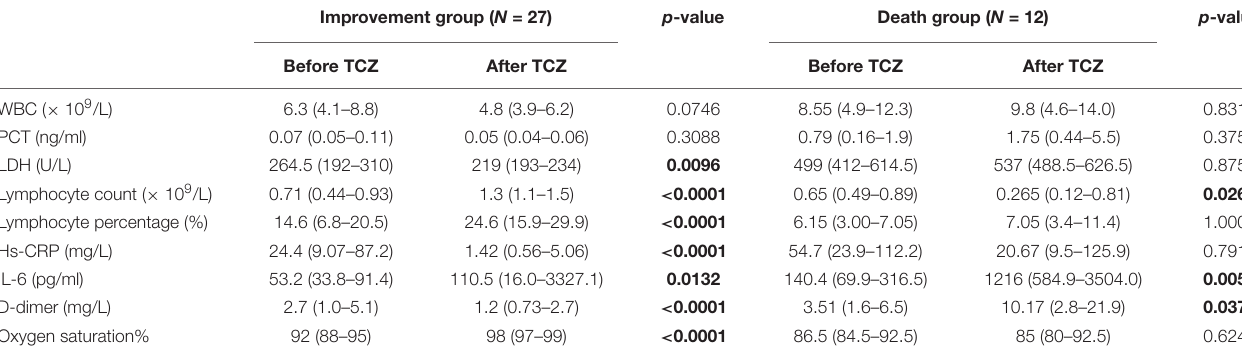
TABLE 3 | Laboratory tests before and after the administration of tocilizumab in the improvement group and the death group. Improvement group ( N = 27) p